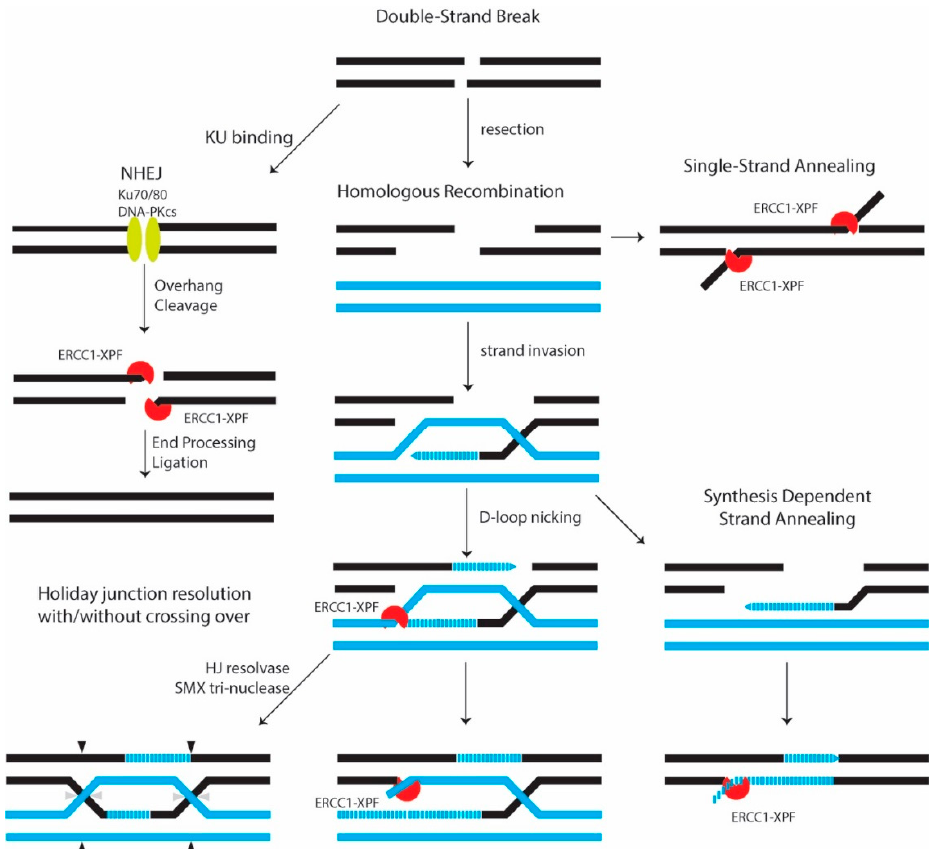
Figure 2. An overview of eukaryotic DSB repair. DSBs in DNA can be resealed through NHEJ (left) without homology requirement. ERCC1-XPF might trim the ends before resealing. Alternatively, DSBs repair can receive 5 (cid:48) → 3 (cid:48) single strand resection followed by invasion, which uses another homologous chromatid as template. This is followed either by re-annealing of the invading strands (synthesis-dependent strand annealing) or formation of a heteroduplex Holliday Junction. After a branch migration on this formed junction, DNA polymerase extends the missing sequence (D-loop formation). Also shown is how ERCC1-XPF may be involved at the different mechanisms of DSB repair. DNA copies from two distinct homologous chromatids are represented in blue and black.